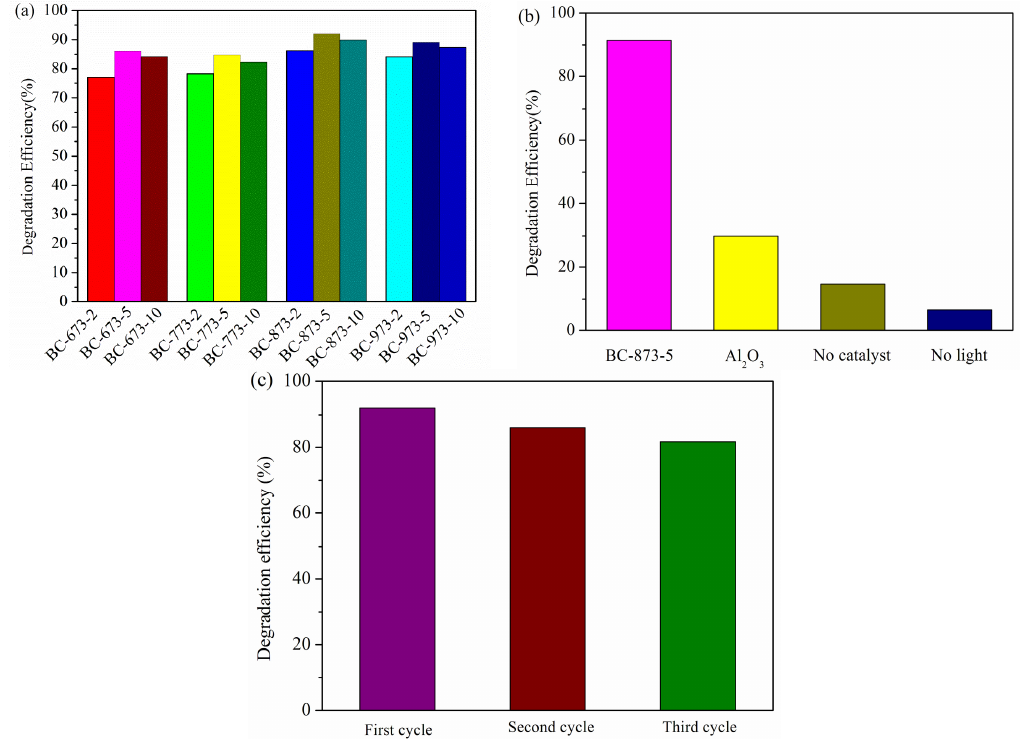
Figure 7. The degradation efficiencies of MG solution over the series of Bi 2 O 3 photocatalyst coatings: ( a ) after irradiating for 180 min; ( b ) control experiment results; and ( c ) the reusability of BC-873-5. Table 1. The reaction rate constants of the samples.